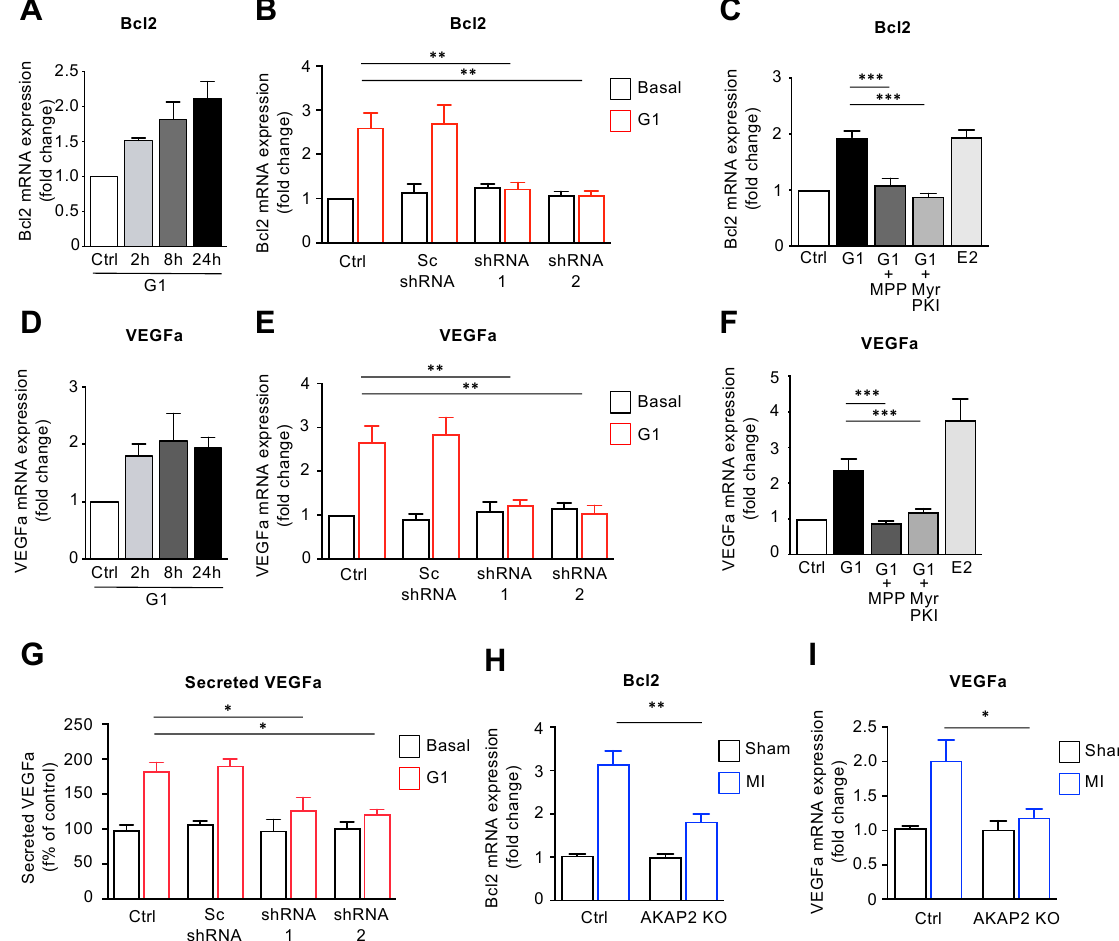
Figure 6. AKAP2 promotes ER α -mediated regulation of Bcl2 and VEGFa in cardiomyocytes. ( A , D ) Time course of G-1- induced Bcl2 ( A ) and VEGFa ( D ) mRNA expression. Rat NVMs were serum starved for 24 h and subsequently treated with 10 − 7 M G1 for the indicated periods of time. Bcl2 and VEGFa mRNA expression was assessed by quantitative real-time PCR. ( B , E ) Rat NVMs were infected by using control lentiviruses or lentiviruses encoding wild type (AKAP2 shRNA 1 and 2) or scrambled AKAP2 shRNAs (sc shRNA). Seventy-two hours after infection, cells were serum-starved for 24 h and subsequently treated with 10 − 7 M G1 for 24 h. Bcl2 and VEGFa mRNA expression was determined by quantitative PCR. Results are expressed as mean ± SE of 3 experiments. ( C , F ) Rat NVMs were serum starved for 24 h and subsequently left untreated (Ctrl) or treated with 10 − 7 M G1 in the absence or presence of 10 − 5 M MPP or Myr-PKI. Control stimulations with 10 − 7 M 17 β -estradiol (E2) were performed to promote direct ER activation. Bcl2 and VEGFa mRNA expression was assessed by quantitative real-time PCR. ( G ) Rat NVMs were infected and treated as indicated in ( B ). VEGFa amounts in culture media was assessed by ELISA. Results are expressed as mean ± SE of 3 experiments. ( H , I ) Cardiac lysates were prepared from control (Ctrl) or cardiomyocyte-specific AKAP2 KO mice 2 weeks after sham operation or LAD ligation (MI). Bcl2 and VEGFa mRNA expression in cardiac lysates was assessed by quantitative PCR. Ctrl-sham n = 4, Ctrl-MI n = 4, AKAP2 KO-sham n = 4, AKAP2 KO-MI n = 4; * p < 0.05, ** p < 0.01 and *** p <